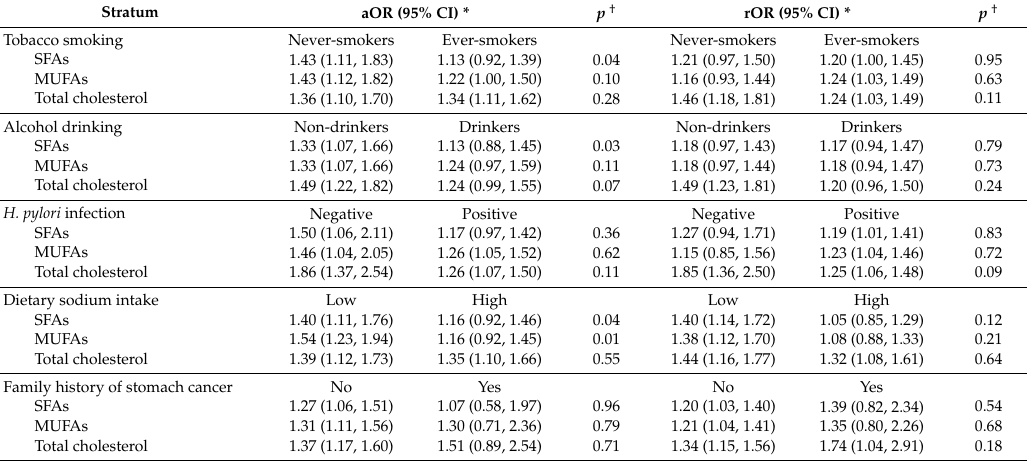
Table 5. The associations between dietary saturated, monounsaturated fatty acids, total cholesterol (high vs. low) and stomach cancer, stratified by tobacco smoking, alcohol drinking, H. pylori infection, and dietary sodium